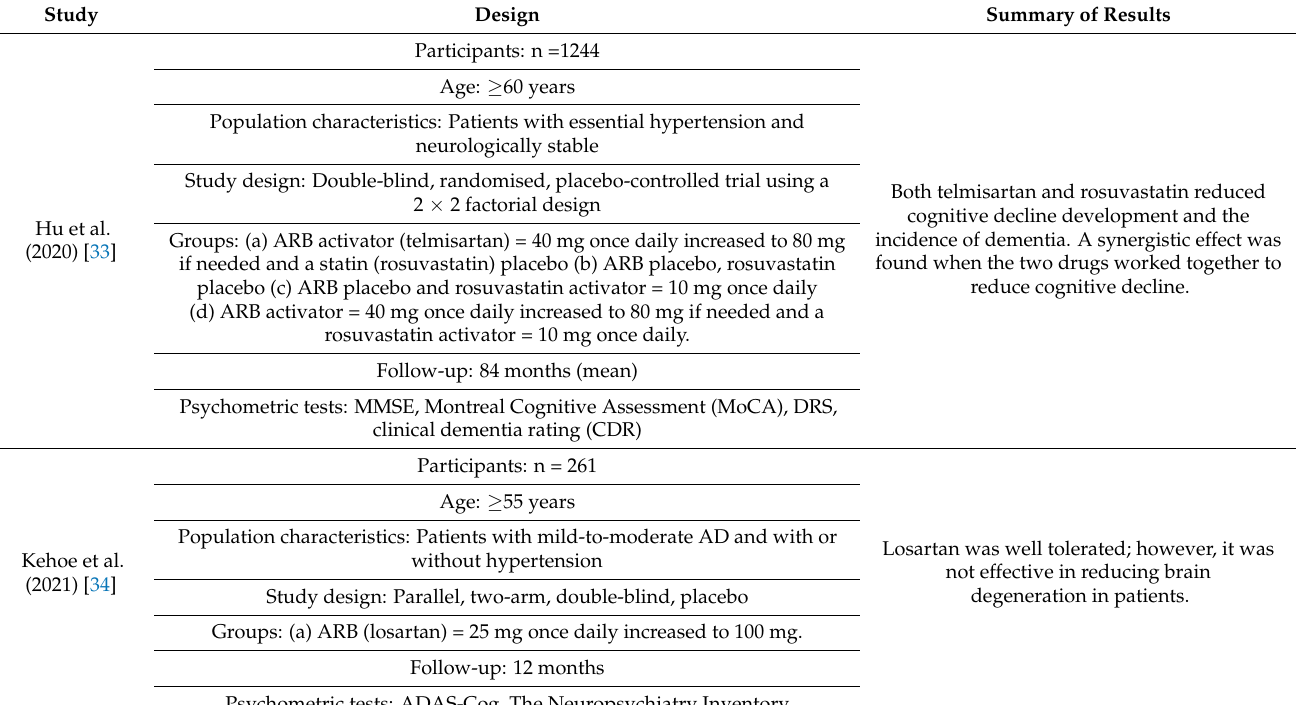
Population characteristics: Patients with essential hypertension and neurologically